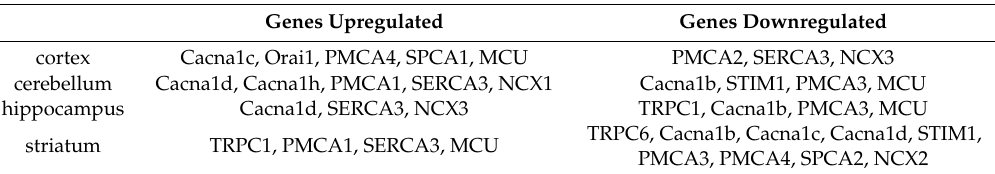
Table 1. Regional changes in gene expression in rat brain elicited by chronic ketamine administration at 30 mg / kg. The data have been extracted from